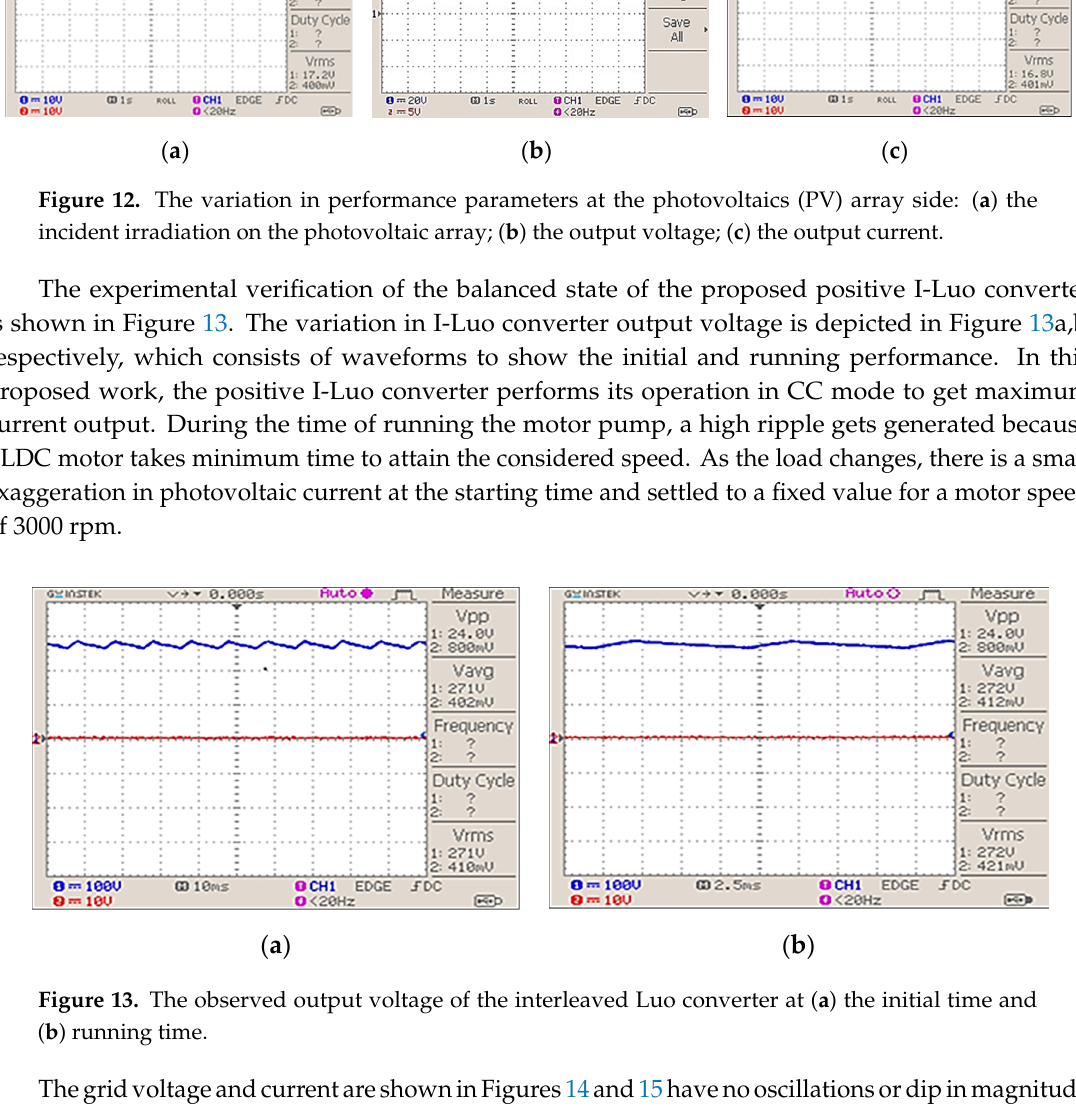
Figure 14. Grid voltage during ( a ) starting and ( b ) execution.